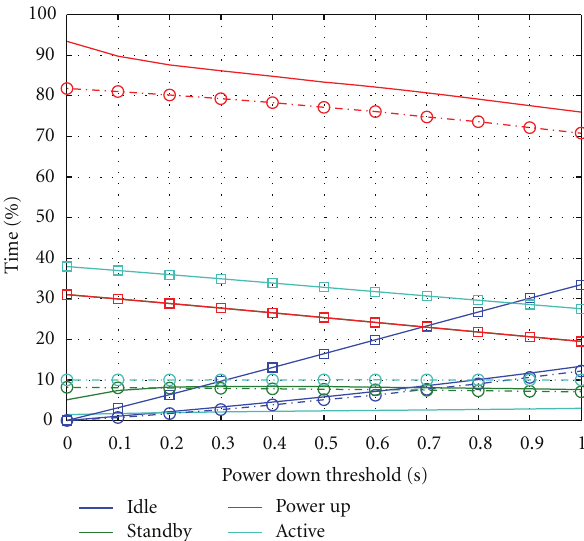
Figure 9: Energy estimates for P ow e r Up De lay = 0 . 3